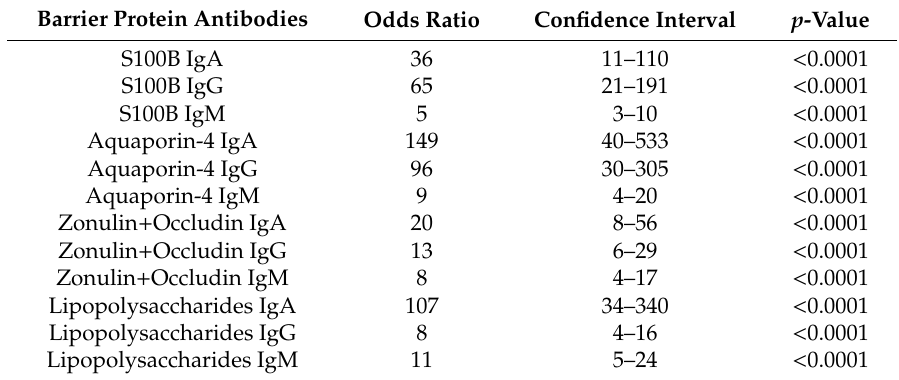
Figure 5. Scatter matrix plots illustrating positive linear relationships between barrier proteins for ASCA-positive subjects for IgG, IgM, and IgA. All linear relationships were statistically significant ( p < 0.0001). ASCA – Anti- Saccharomyces cerevisiae antibodies; LPS – Lipopolysaccharides; ZON/OCC – Zonulin+Occludin; S100B – S100 calcium-binding protein B. Table 1. Odds ratios for developing barrier antibodies with anti- Saccharomyces cerevisiae antibodies (ASCA) positive subjects compared with ASCA-negative subjects.